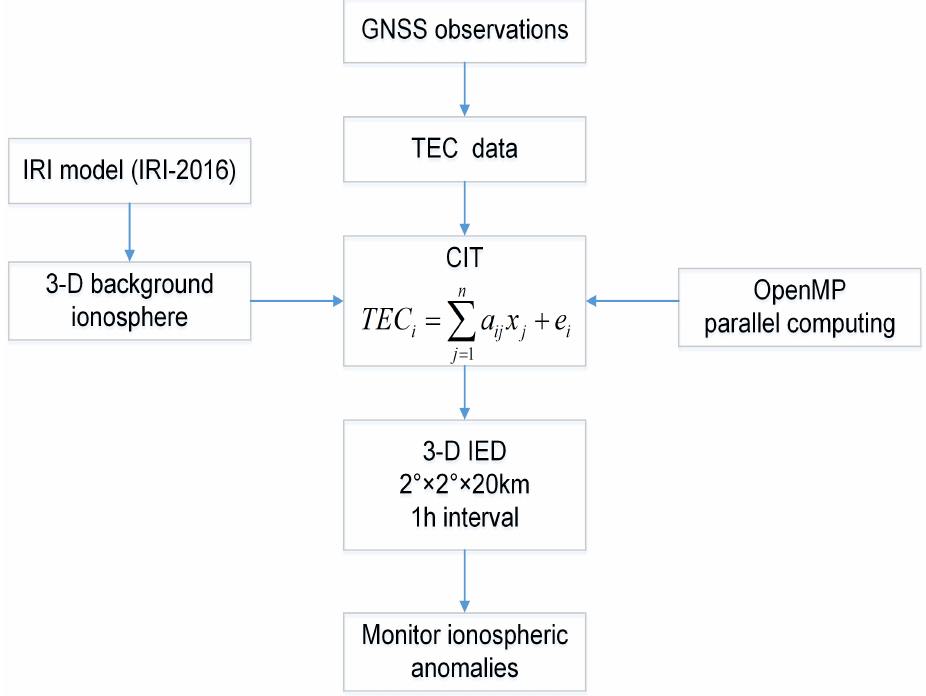
Figure 2. The processing procedures of Ionospheric Electron Density (IED) reconstruction and application. IRI, International Reference Ionosphere; TEC, Total Electron Content; CIT, Computerized Ionospheric